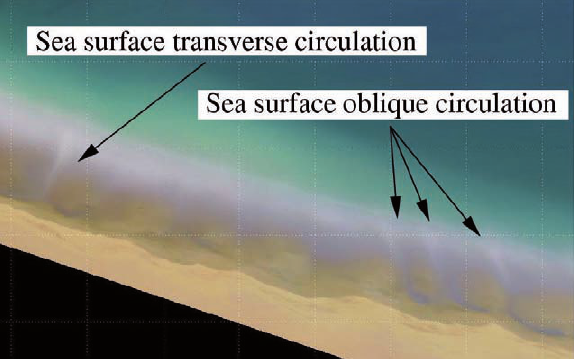
Fig . 6. – Sea-surface transverse and oblique circulations, 3 March